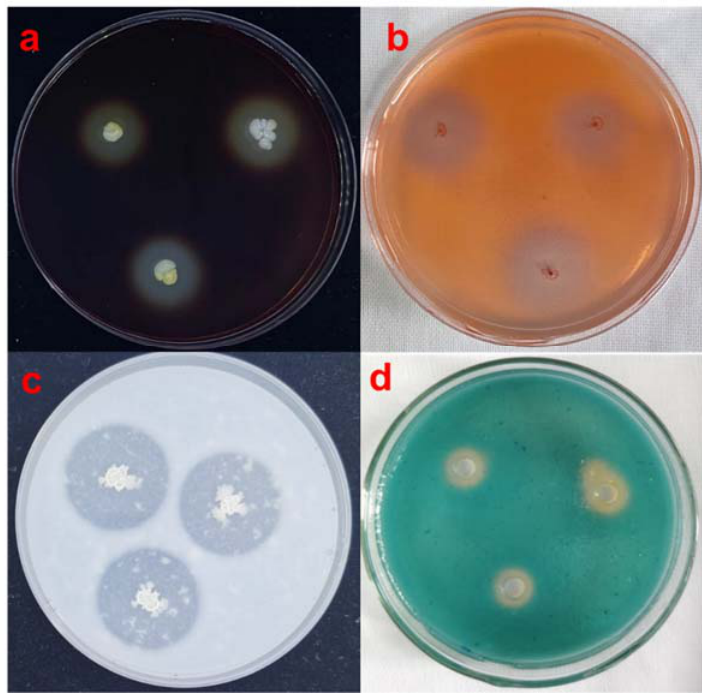
Figure 6. Detection of ( a ) amylase, ( b ) cellulase, ( c ) protease, and ( d ) siderophore activity of Bacillus velezensis SBB.